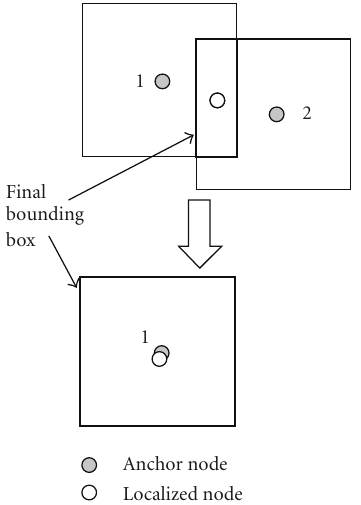
Figure 8: Location resolver algorithm resilience against failed nodes. First, both Anchor nodes 1 and 2 can hear the localized node. Then, Anchor node 2 is lost but at least a rough location is still